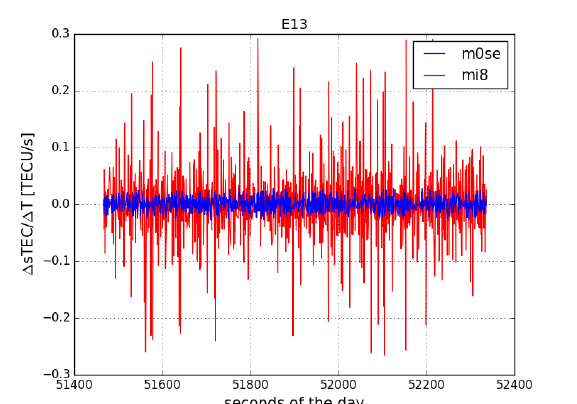
Figure 13. The trends of ∆ sTEC / ∆ t with respect to Galileo satellite E13 for M0SE and for Xiaomi Mi8 are respectively depicted in blue and red. Table 5. RMSEs of Xiaomi Mi8 moving median series for satellite E13 for different time windows.